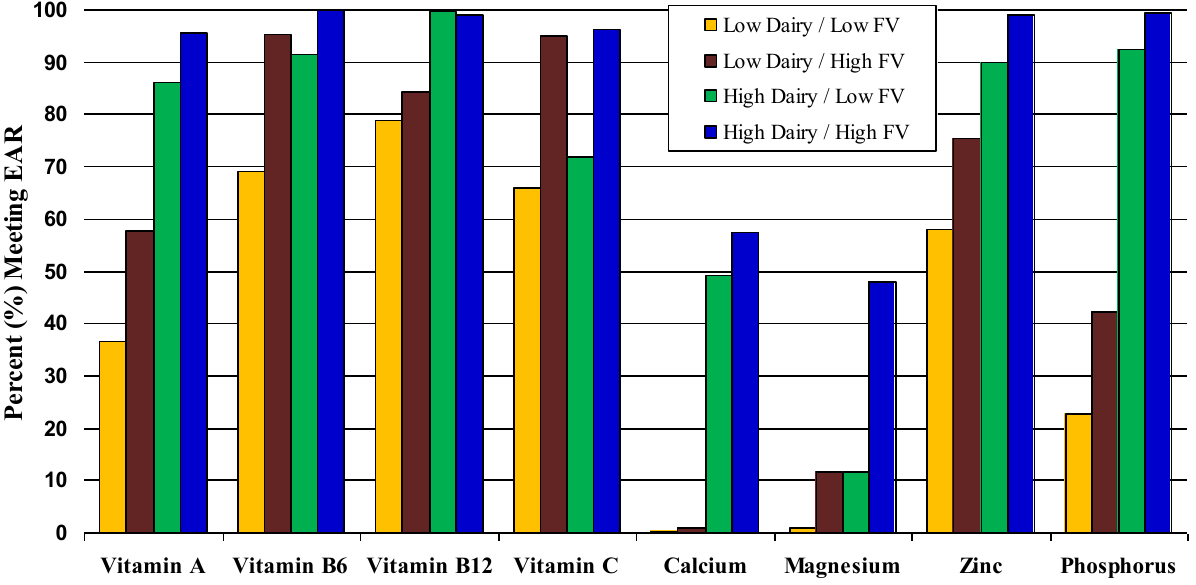
Figure 1. Percent of 14–18 year-old girls meeting EAR according to combined effects of fruits and vegetables and whole dairy. Low ( vs. high) fruit and vegetable intake: <50% ( vs. ≥50%) of recommended 8 servings of total fruit and vegetables/day. Low ( vs. high) dairy: <75% ( vs. ≥75%) of recommended 3 dairy